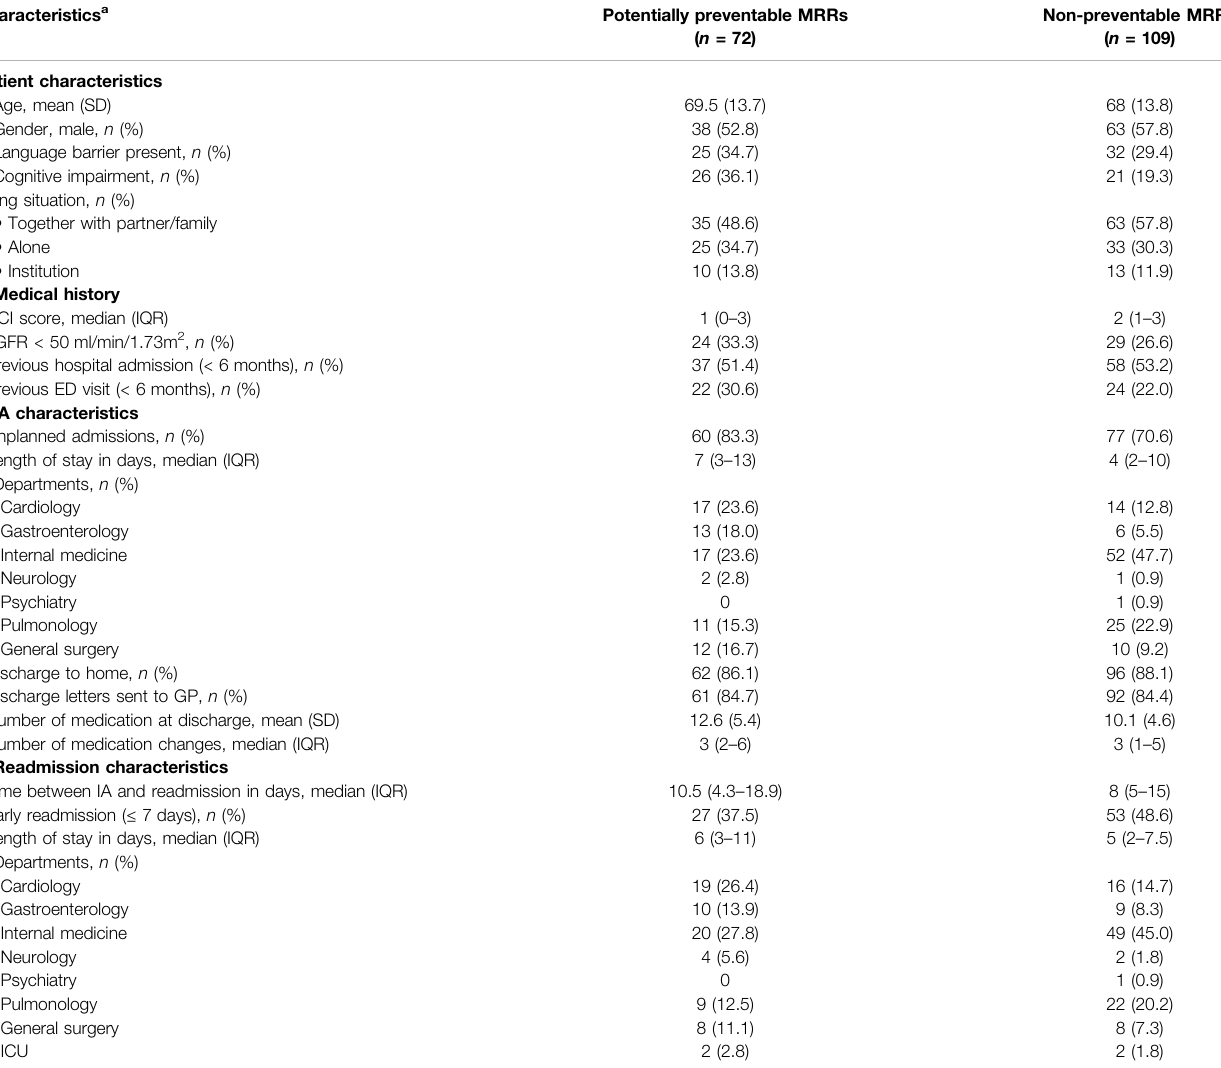
TABLE 1 | Baseline characteristics of potentially preventable and non-preventable medication-related readmissions (MRRs) included in this study.